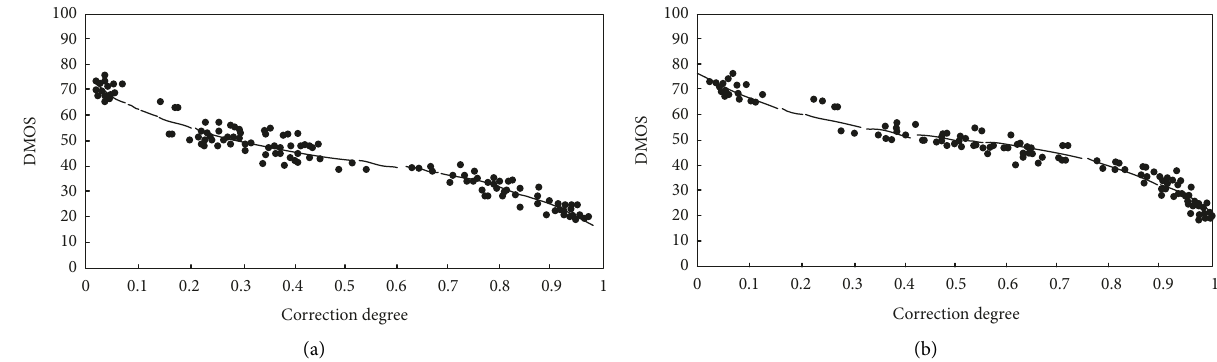
Figure 4: Edge correction scatter of white noise distortion image. (a) Control group. (b) Experience group.